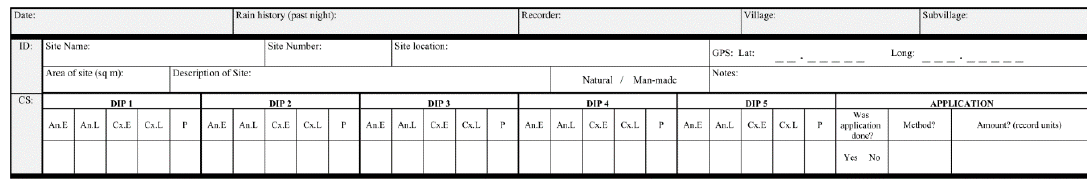
Figure 1. Location of 12 villages included in the larviciding intervention in the Mvomero District of Tanzania. Locations are approximate.